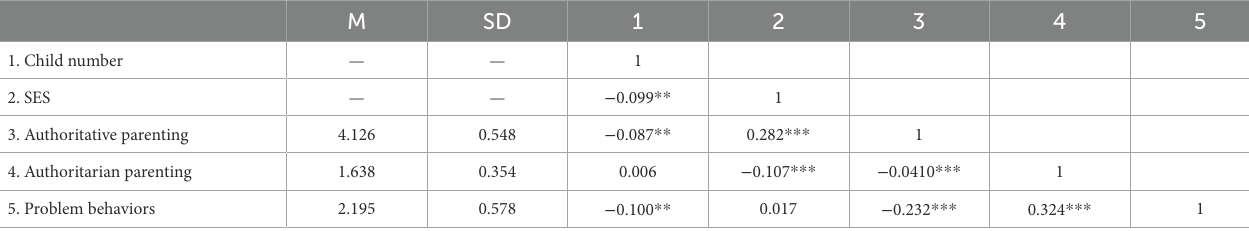
TABLE 2 Means, standard deviations, and intercorrelations of variables in this study.